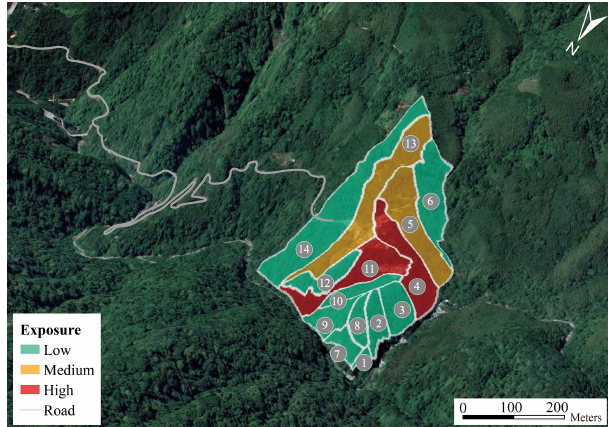
Figure 10. Exposure level mapping of landslide referring to units around the Neikuihui tribe (background: modified from © Google Earth 2021; aerial: ESRI ArcGIS 10.4).